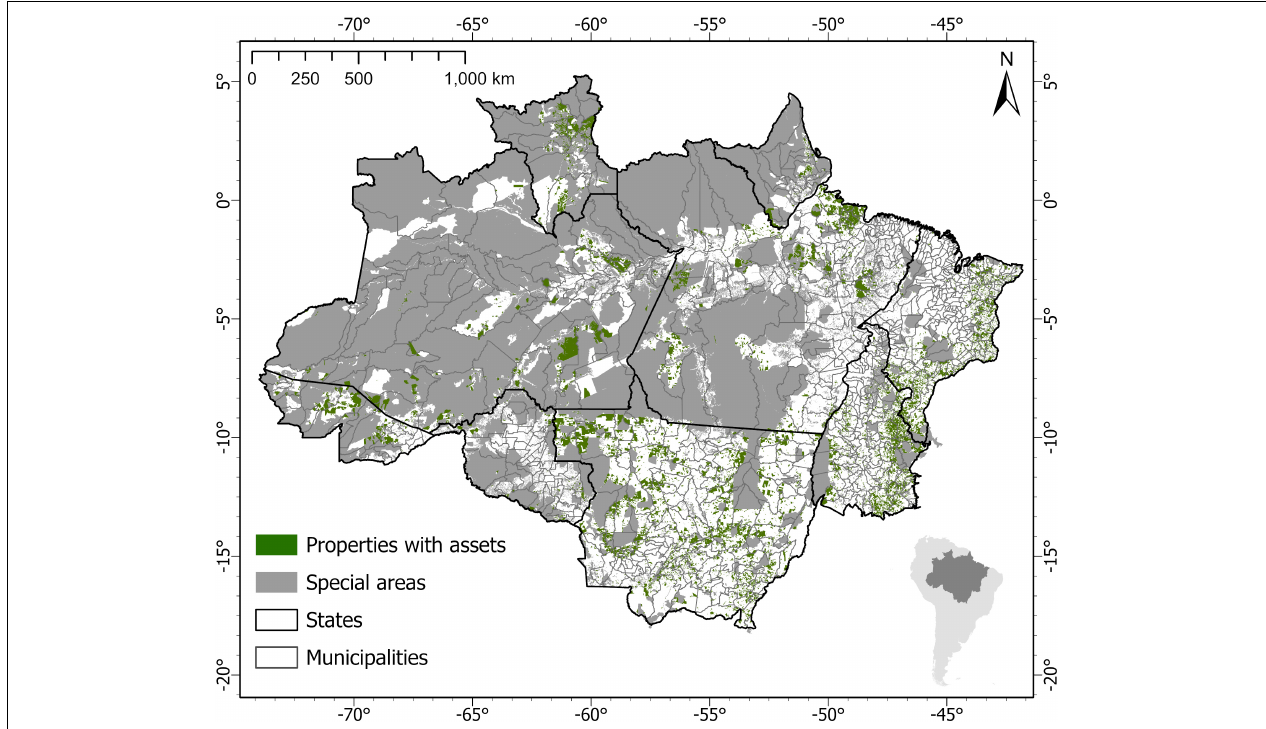
FIGURE 1 | Distribution of properties with native vegetation assets in the Legal Amazon states. Assets are the remaining native vegetation in private rural properties beyond what are required for Legal Reserves and Permanent Preservation Areas, and which can be legally deforested.